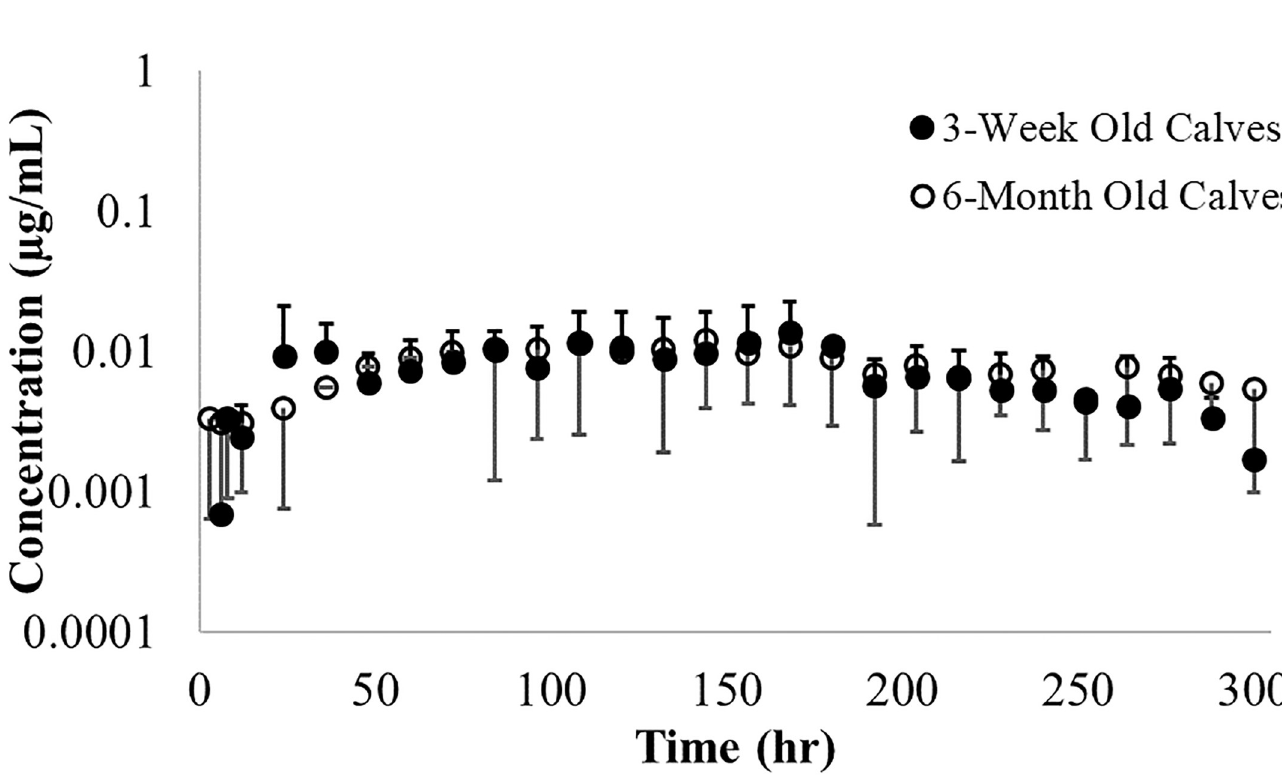
Fig 7. Mean interstitial fluid ± SD concentrations of tulathromycin. Tulathromycin was a after single S.C. injection of 2.5 mg/kg tulathromycin in 3-week old (solid circles) and 6-month old calves (open circles).